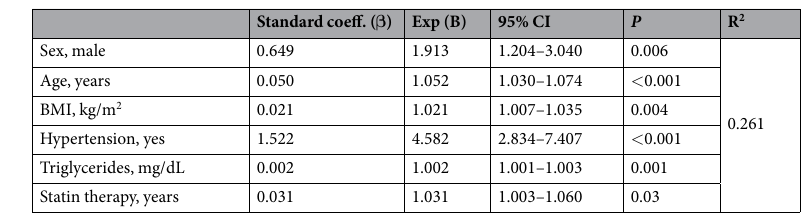
Table 4. Factors associated with the presence of type 2 diabetes mellitus in clinically-defined heterozygous familial hypercholesterolemia patients ( ≥ 6 DLCN points). DLCN denotes Dutch Lipid Clinic Network; BMI, body mass index. Independent variables included in the model: sex, age, BMI, smoking status, hypertension, tendon xanthomas, baseline LDL and HDL cholesterol and triglyceride concentrations, genetic diagnosis and statin therapy duration.